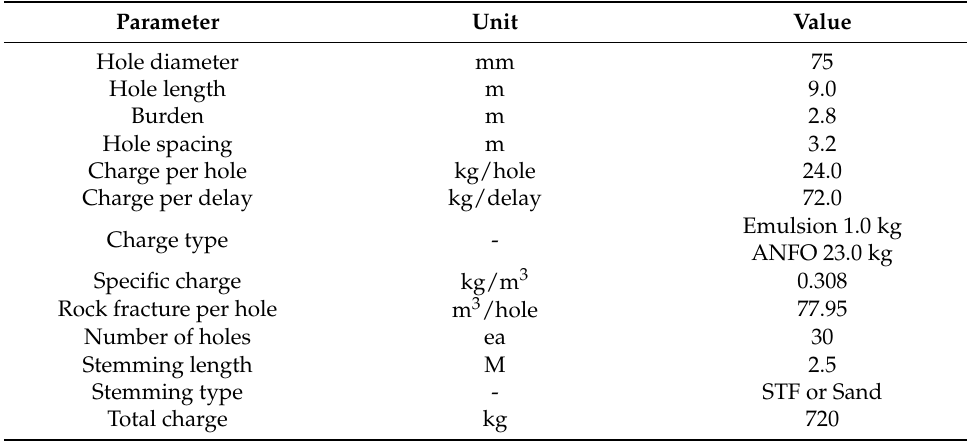
Figure 10. Bench blasting design of full ‐ scale blasting experiment. Table 3. Main parameters of the full ‐ scale bench blasting experiment.